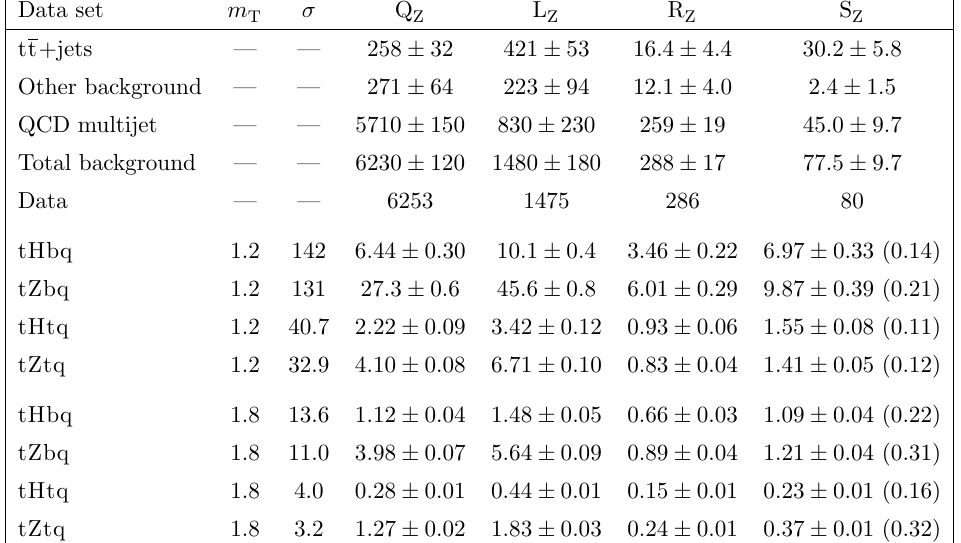
, L , R , and S regions for the data and Z Z Z Z